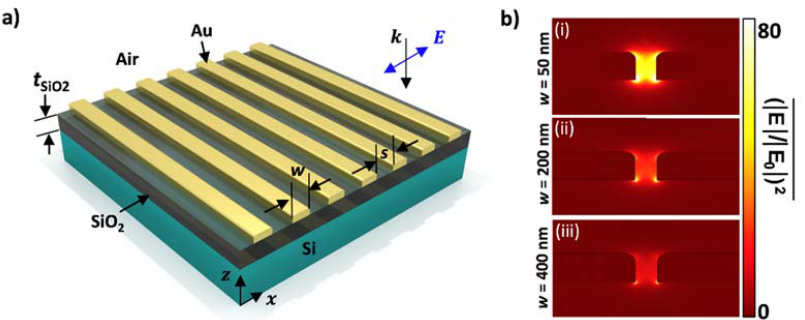
Figure 1. Depiction of the modeled grating of Au plasmonic nanowires bonded to a SiO 2 thin film by a Ti adhesion layer atop a Si substrate. ( a ) Shows a schematic of the simulated structure under the presence of λ 0 = 785 nm light incident normal to the surface and polarized in the x ‐ direction, perpendicular to the length of the nanowires. The parameters swept in this study were wire width ( w ), electrode spacing ( s ), and SiO 2 thickness ( t SiO ₂ ); ( b ) Optical enhancement hotspots in 2D cross-sections of structures modeled as infinite wires with t SiO ₂ = 330 nm, s = 10 nm, and (i) optimized value at w = 10 nm, (ii) median value at w = 200 nm, and (iii) minimum value at w = 400 nm.